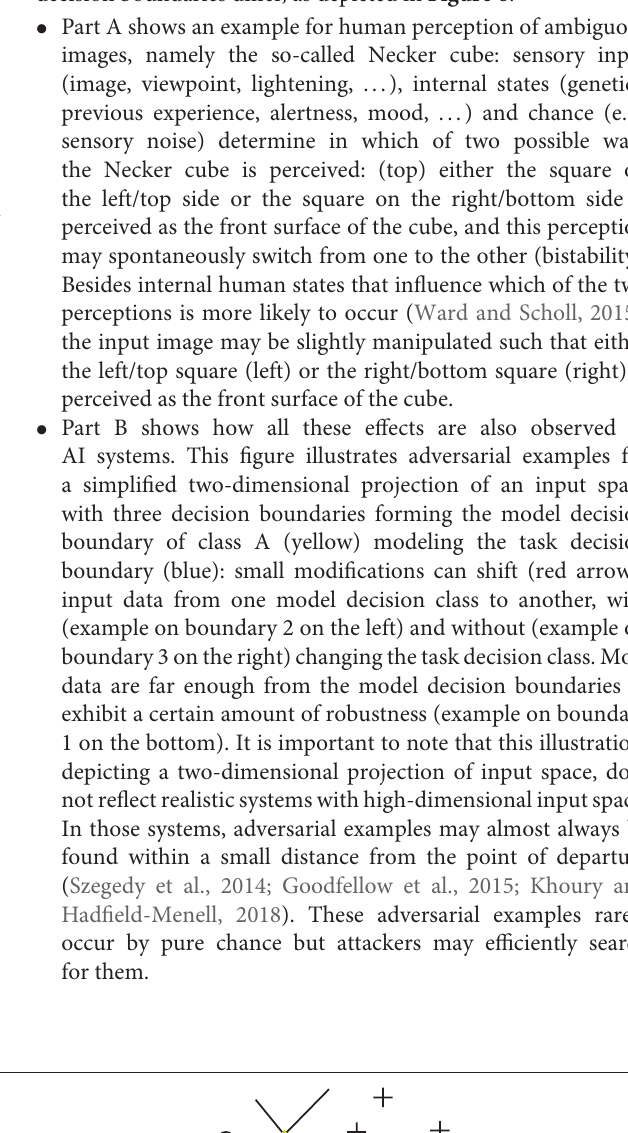
Frontiers in Big Data |